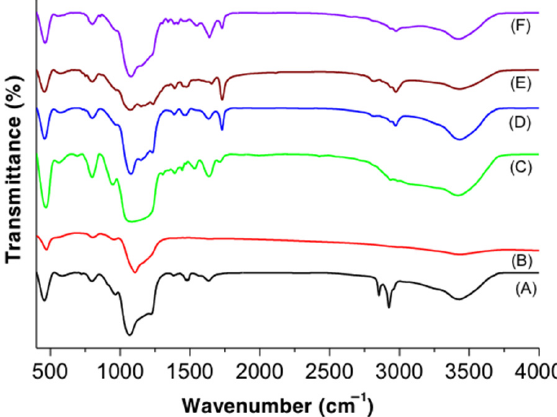
Figure 2 . FTIR spectra of the modified silica nanoparticles: ( A ) as-made MSNs, ( B ) hexadecyltrimethylammonium bromide (CTAB)-free MSNs, ( C ) MSN–Br, ( D ) MSN-PDEAEMA, ( E ) MSN-PDEAEMA-cysteine (Cys), and ( F ) MSN-PDEAEMA-Cys-POEGMEMA.